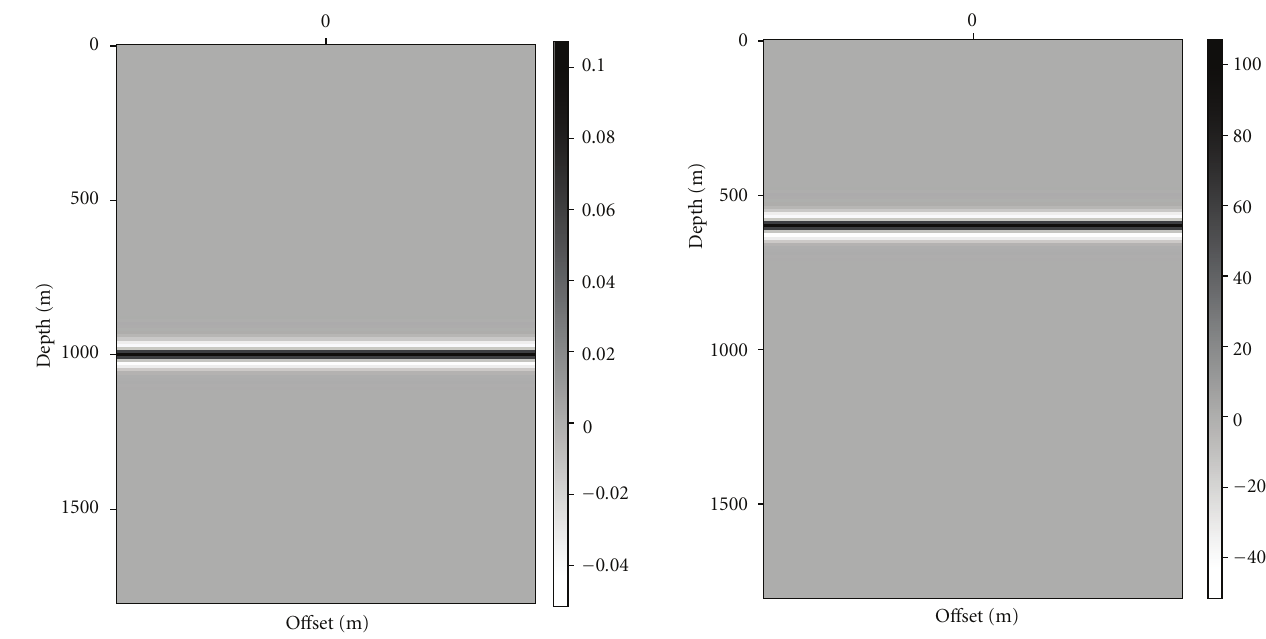
Figure 1: vp, velocity perturbation. Figure 2: dn, density